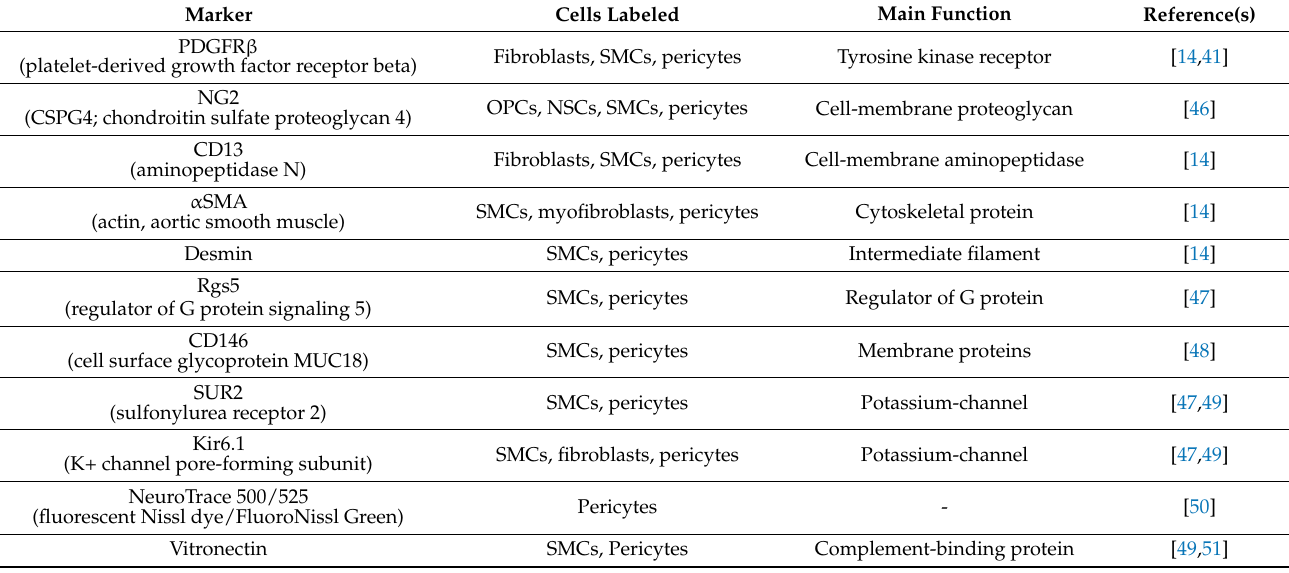
Table 1. Common markers used to identify pericytes in the central nervous system of mice that also label other cell types.